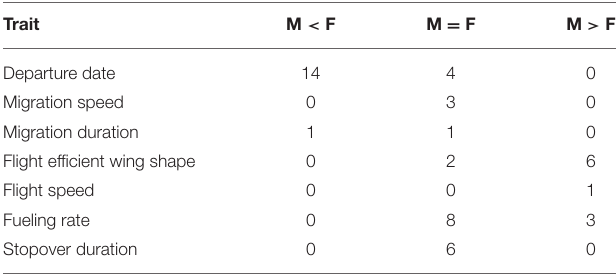
TABLE 2 | Summary of sex effects in departure date and traits related to spring migration speed from published studies of migratory songbirds (see Table S1 ).